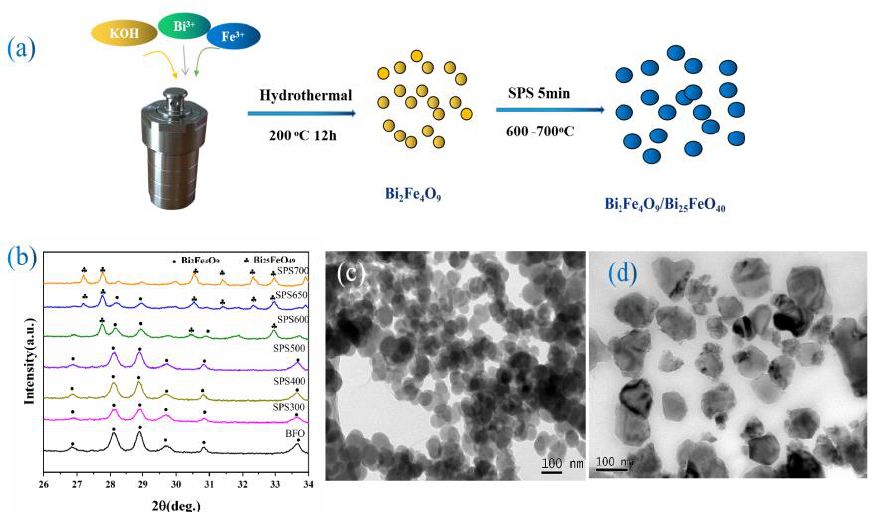
Figure 1. ( a ) Preparation scheme for bismuth ferrites, ( b ) X-ray diffraction (XRD) spectra of as-prepared samples, ( c ) SEM image of untreated BFO, ( d ) SEM image of SPS650.